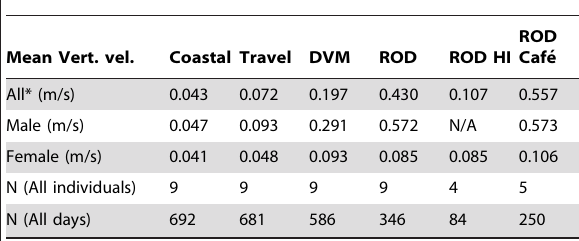
Table 1. White shark mean vertical velocities for different dive behavior clusters measured from a subset of archival records from recovered PAT